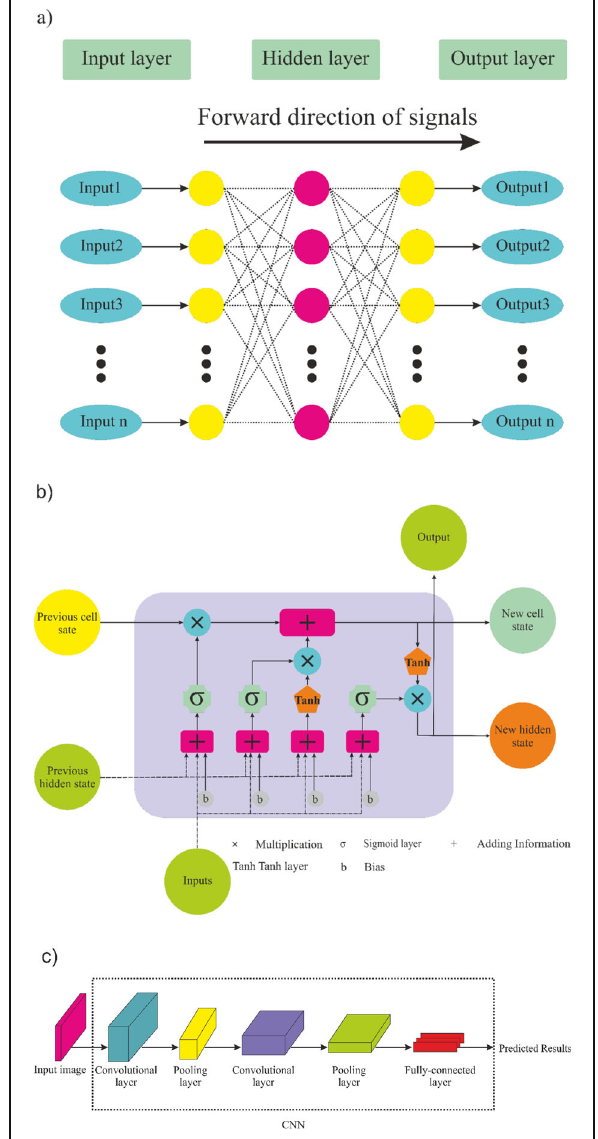
Fig. 5 Schematic structure of a feed forward neural networks (FFNNs), b long – short-term memory (LSTM), and c convolutional neural networks